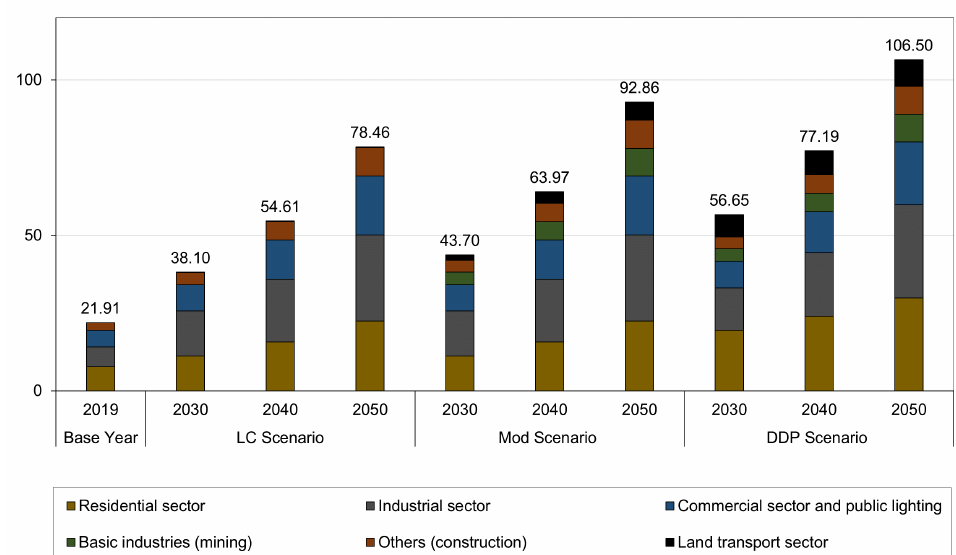
Figure 7. Electricity demand per sector in TWh for the LC, Mod, and DDP scenarios.